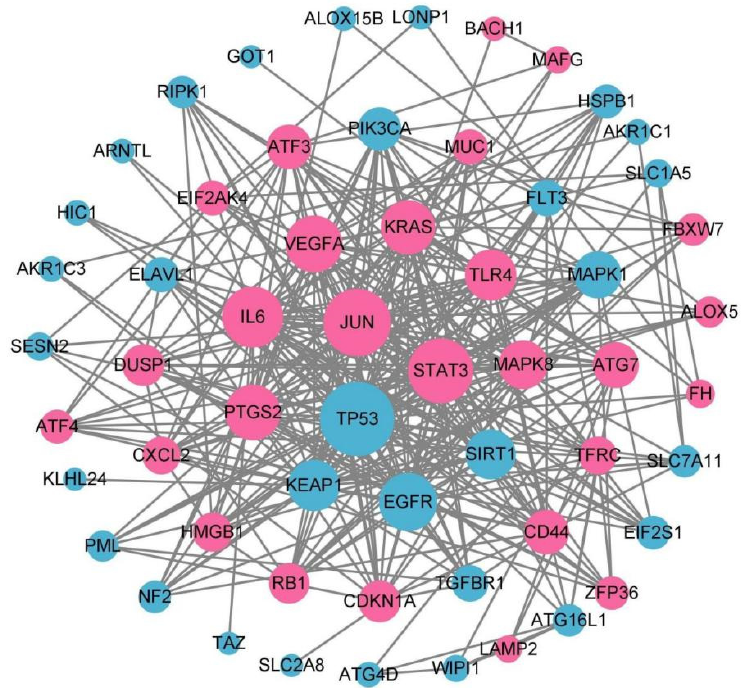
Figure 5. PPI network constructed with ferroptosis-related DEGs. Red indicates genes that are up-regulated, whereas blue indicates genes that are down-regulated.